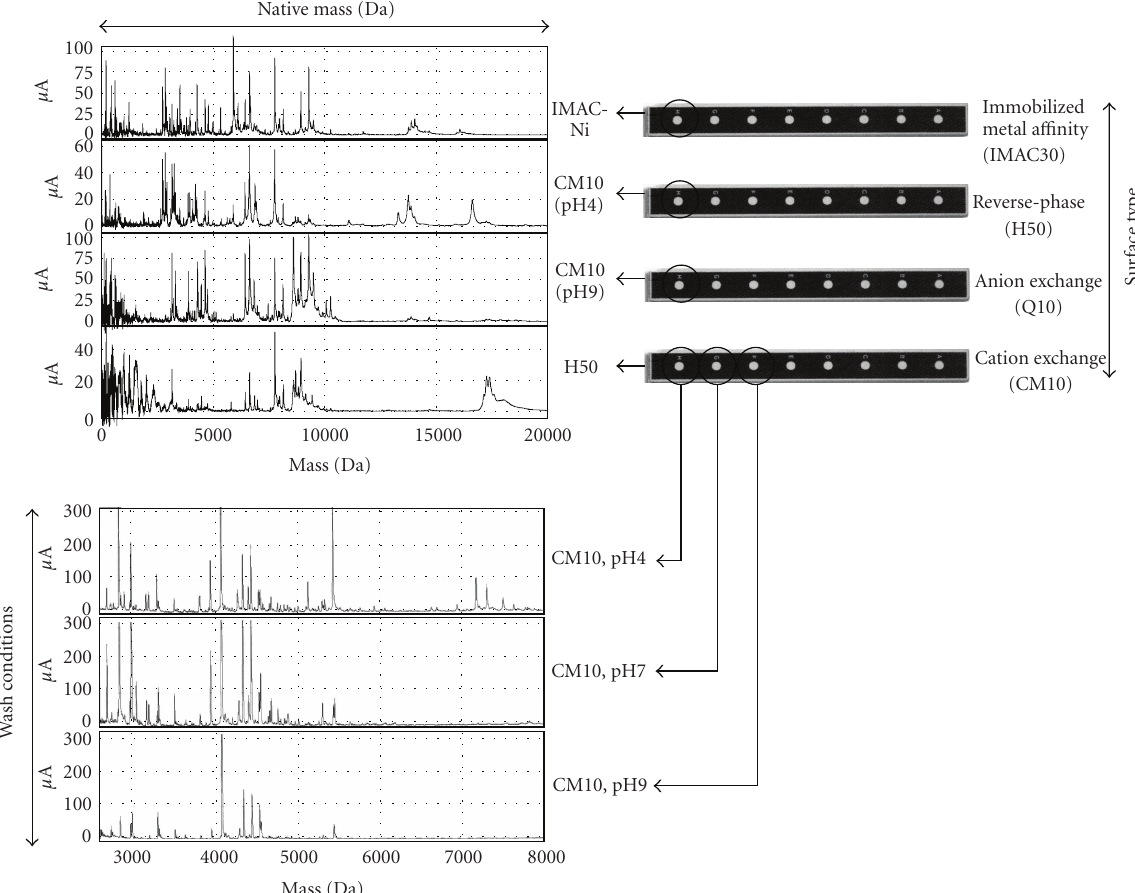
Figure 1: E ff ects of di ff erent ProteinChip array surfaces and wash conditions. The combination of ProteinChip array surface types and wash conditions maximize the potential for protein biomarker